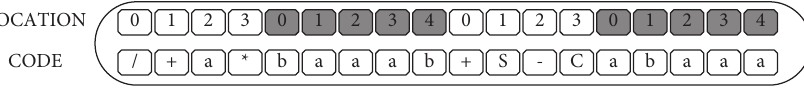
Figure 1: Randomly generated dual-gene chromosomes.